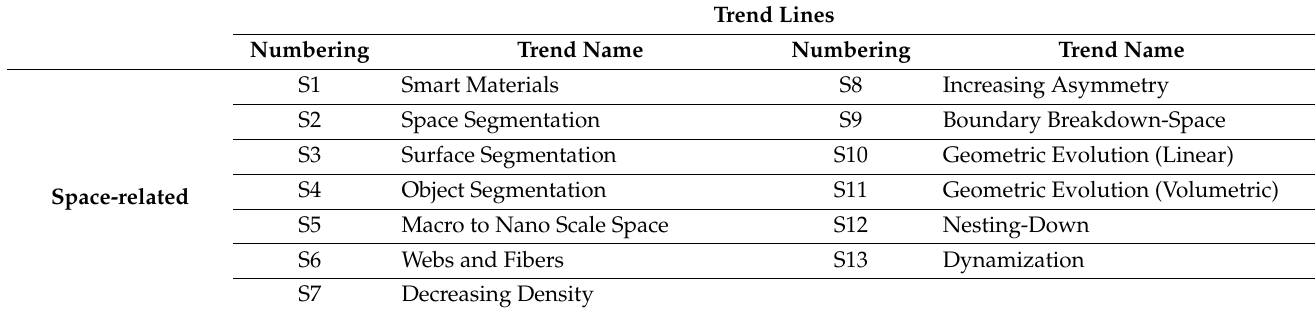
Table 1. The 37 trend lines of evolution.